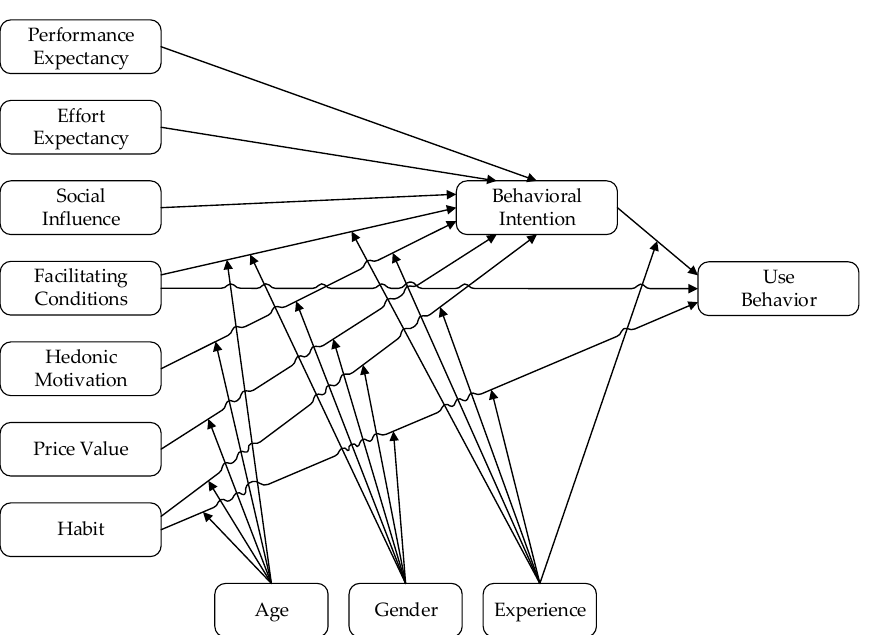
Figure 3. Unified Theory of Acceptance and Use of Technology (version 2). Adapted from Ven- katesh, et al. [12].